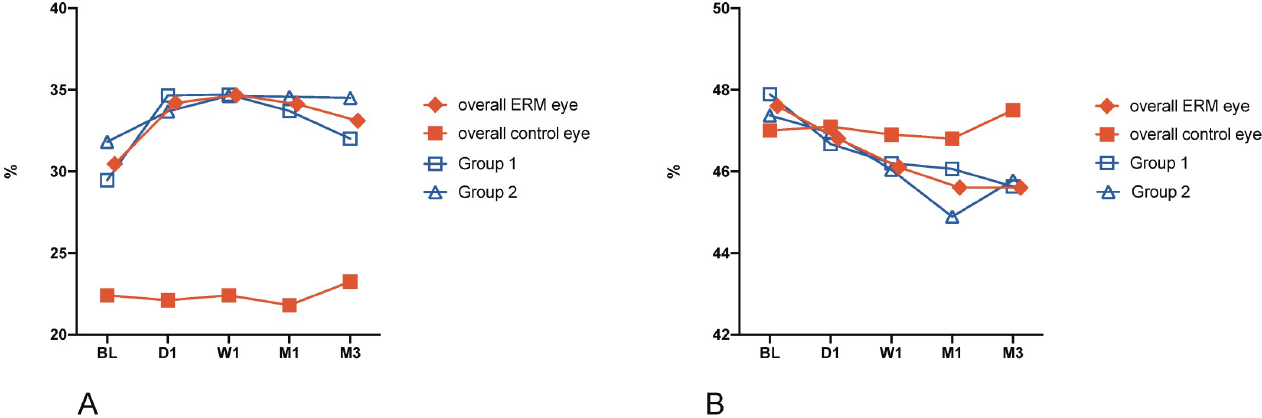
Fig 2. Vessel density (VD) of the superficial retinal plexus was assessed in ETDRS grid locations 1 to 5. (A) VD of the foveal and centermost ETDRS location 1 (VD1); (B) Mean VD of the parafoveal and surrounding ETDRS subfields 2–5 (VD2-5), representing the inner circle of the ETDRS grid. Data are presented as mean; BL = baseline, W1 = week 1, M1 = month 1, M3 = month 3; Group 1 = ERM stages 1 and 2; Group 2 = ERM stages 3 and 4.